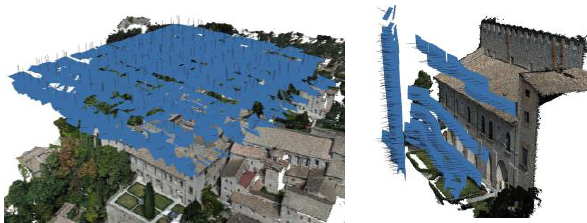
Figure 5. Dense clouds with aligned photos: on the left dataset acquired with the flights 1-3 (planned), on the right the dataset acquired with the flight 4 (manual).